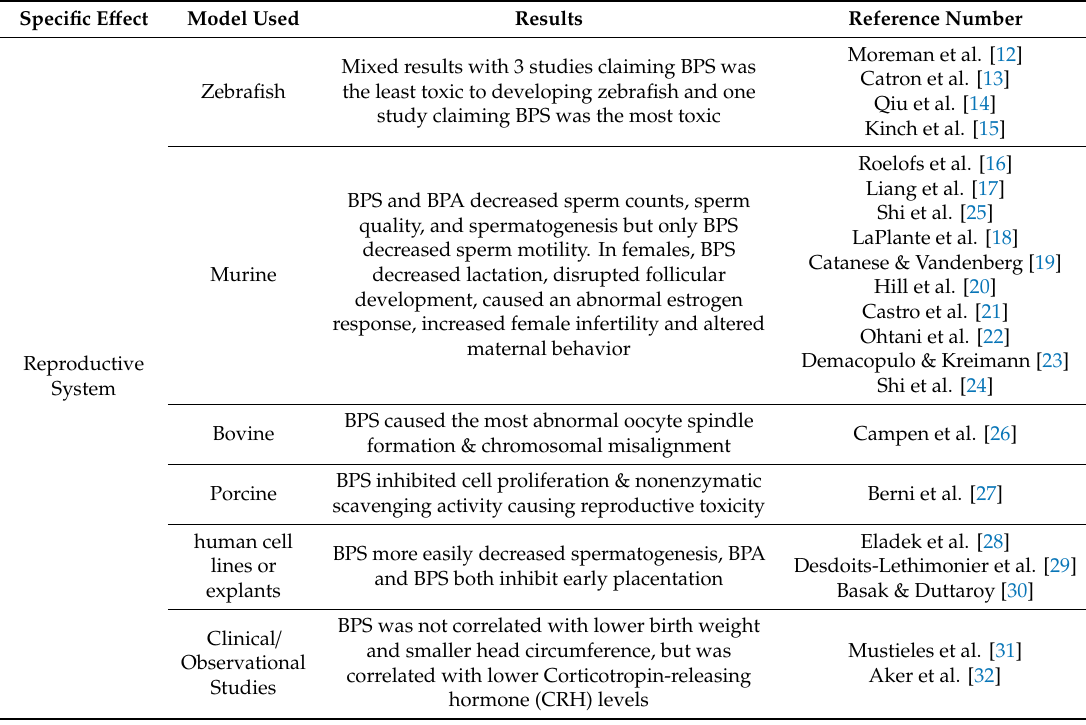
Table 1. Summary of dietary bisphenol S (BPS) exposure and